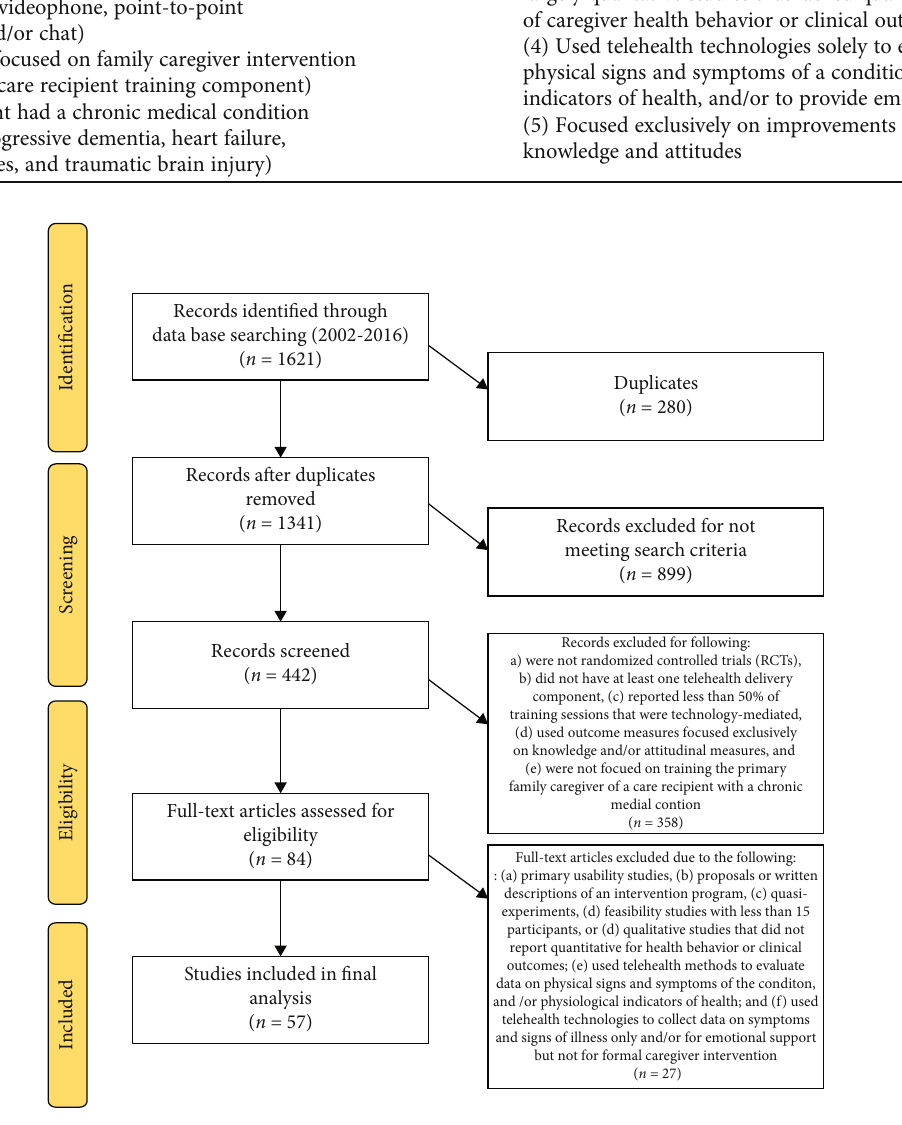
Figure 1: Prisma